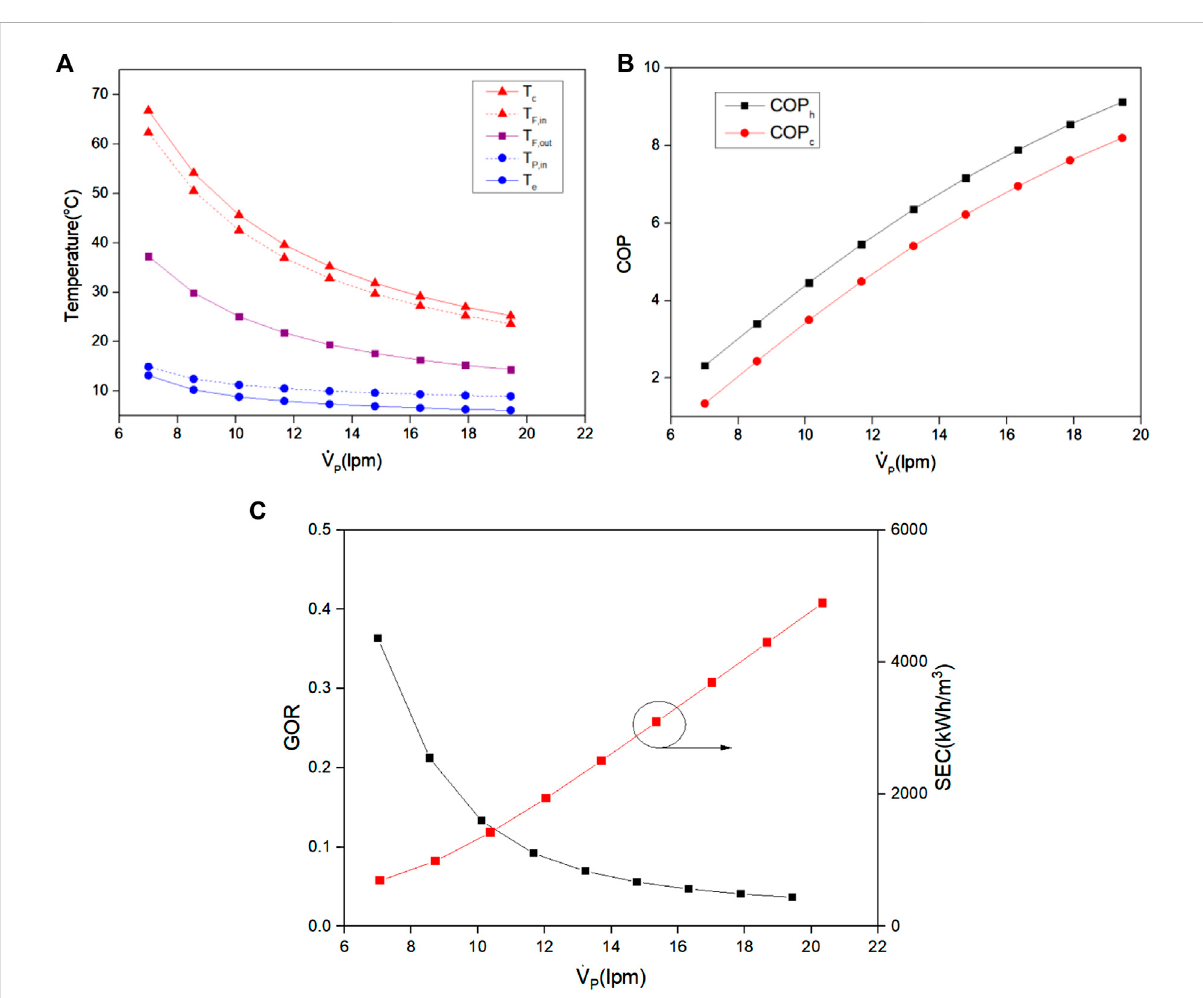
FIGURE 6 Effectsofmass fl owrateofpermeatestream on (A) temperaturesoftheevaporator,condenser,feedwater,andpermeate, (B) COP h and COP c , and (C) GOR and